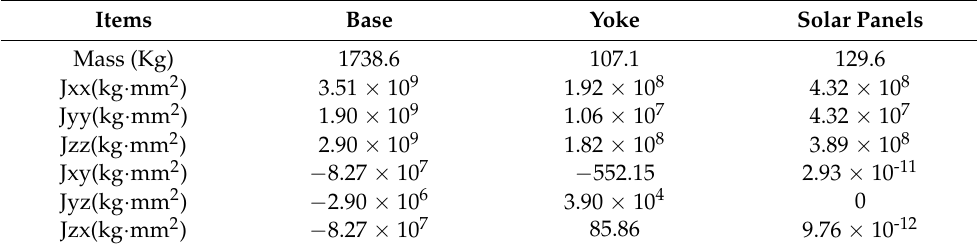
Figure 1. Model of a satellite system. Table 1. Mass and moment of inertia of satellite